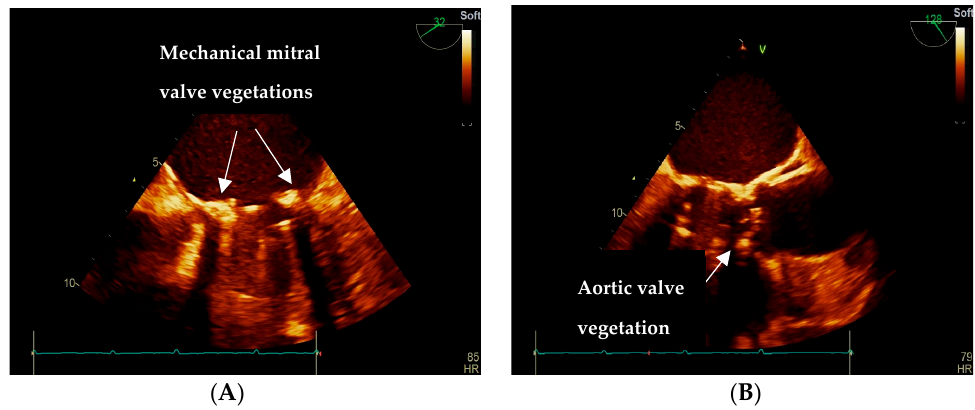
Figure 1. Transesophageal echocardiography. ( A ) Anterior and posterior mitral mechanical valve insertion vegetations. ( B ) Vegetation of the aortic non-coronary cusp (from Cardiology Clinic, “St. Spiridon” Emergency Clinical County Hospital, Iasi, Romania).